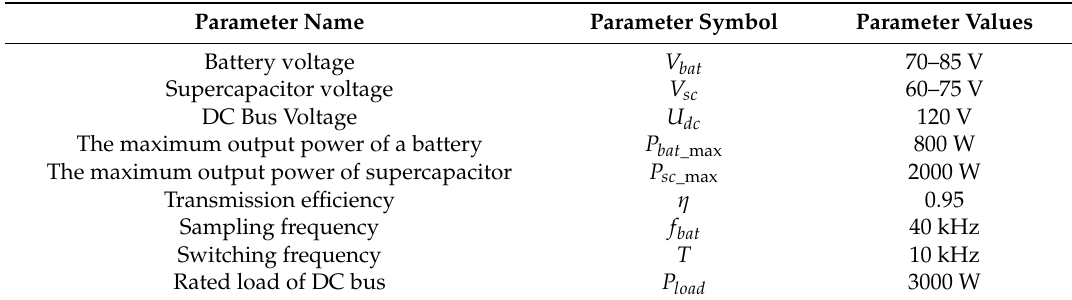
Table 1. Main parameters of the Microgrid model.